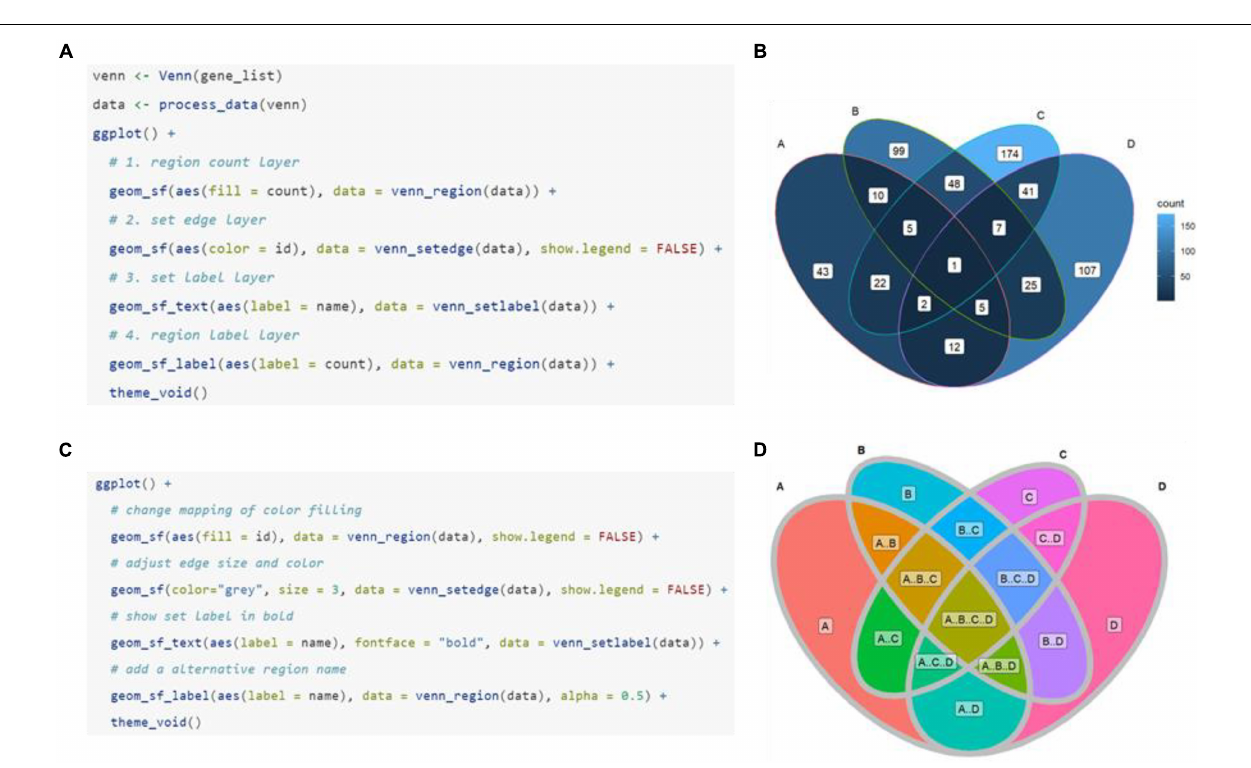
FIGURE 2 | Plotting method of ggVennDiagram. The default manner (A) and returned plot (B) when user calls “ggVennDiagram()” with a four-set list of genes (“gene_list”). (C,D) Stepwise self-customization of the Venn plot by using ordinary ggplot2 functions.